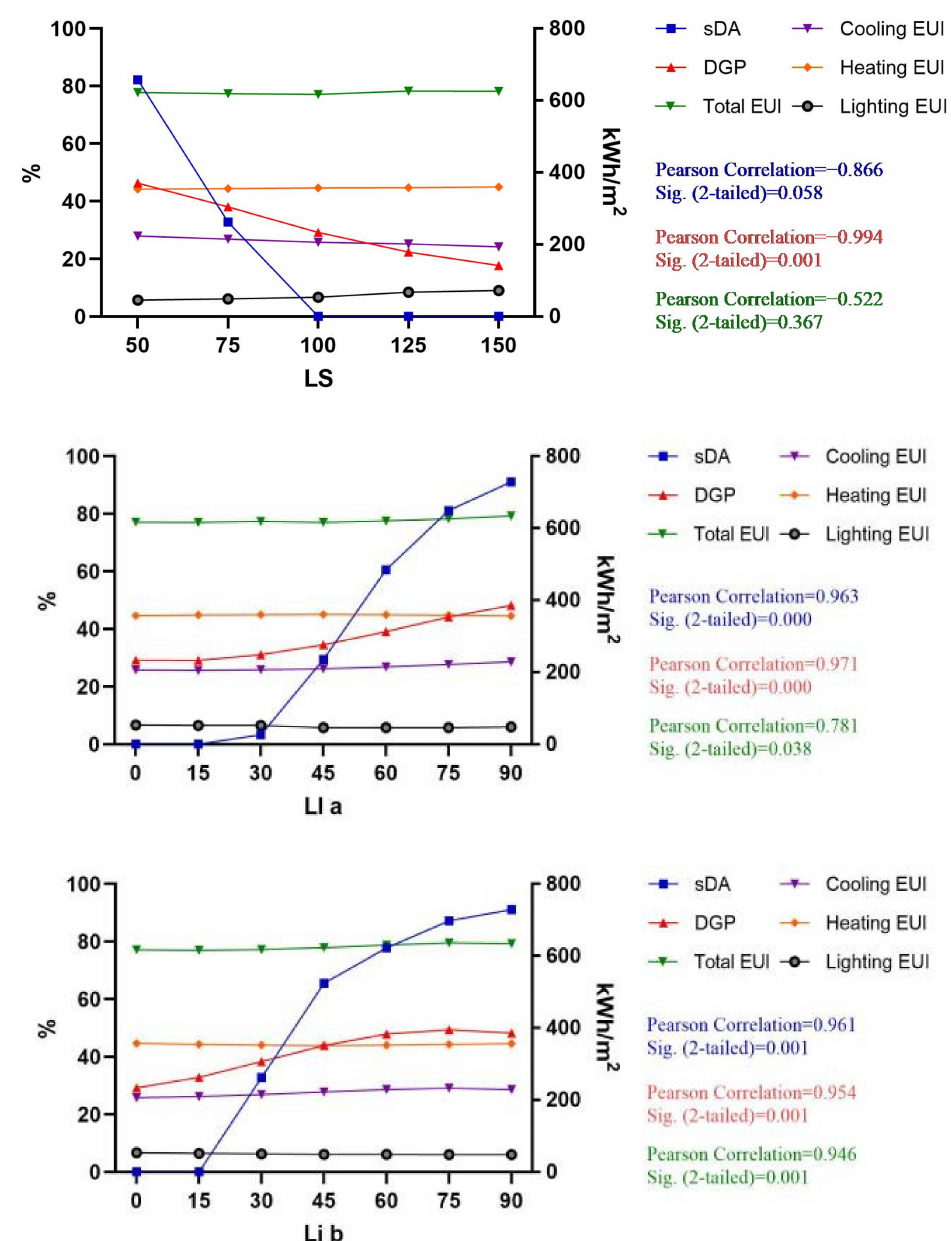
Figure 17. Simulation results of louver